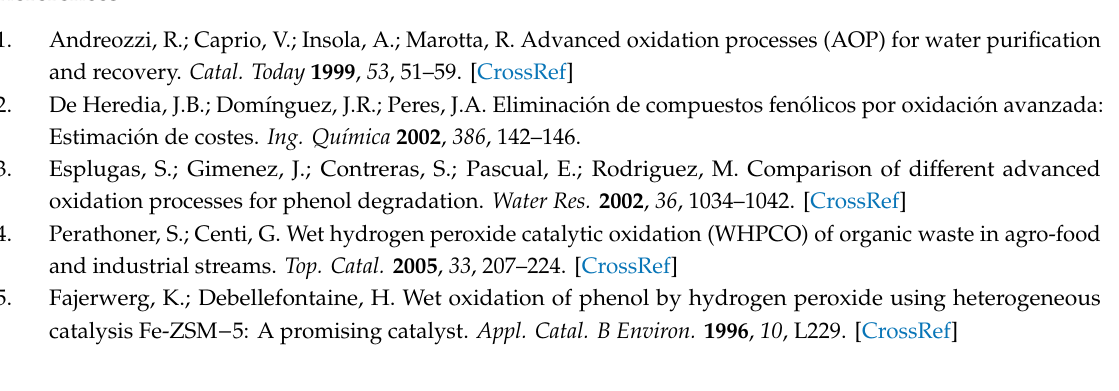
Figure S1: Influence of the operating variables (A–F) and conversions (G–I) on the energetic e ffi ciency of the CWPO process, Table S1: Elementary reactions considered in the CWPO reactor according to the oxidation pathway and kinetic model reported in Diaz de Tuesta et al. (2017), Table S2: Binary coe ffi cients (aij, aji, bij, bji) estimated for the implementation of the UNIQUAC thermodynamic model in the simulator software, Table S3: Theoretical oxygen demand (ThOD) and total organic carbon (TOC) of each compound